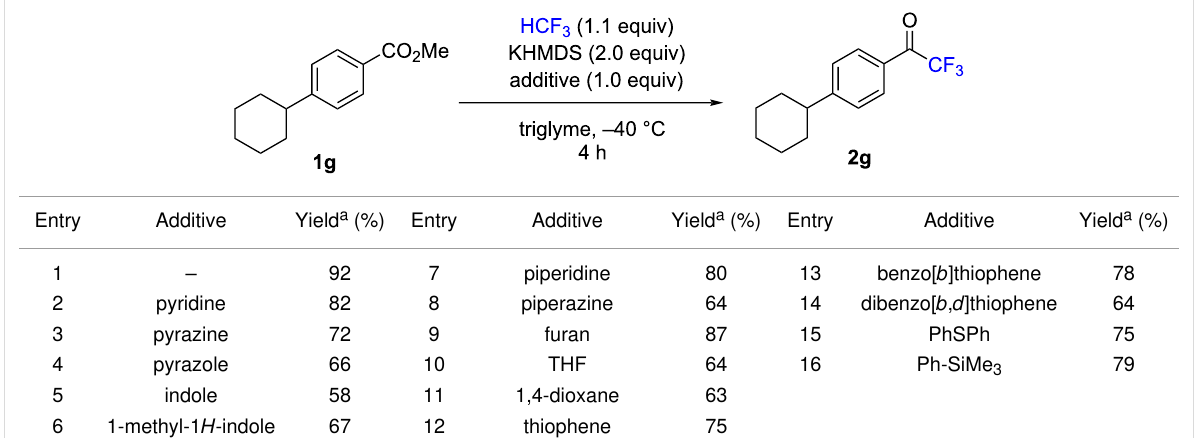
Table 2: Tolerance of various pharmacophores under the trifluoromethylation